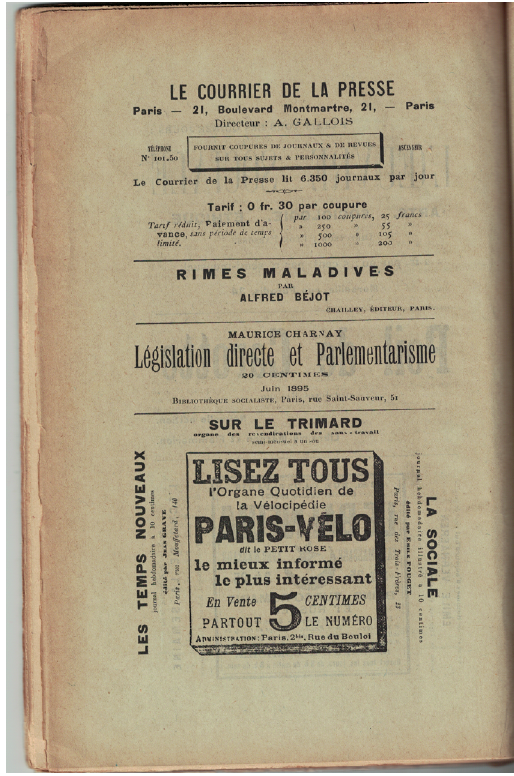
La Revue blanche , 9.50 (1 July 1895), between p. 48 and the end of the